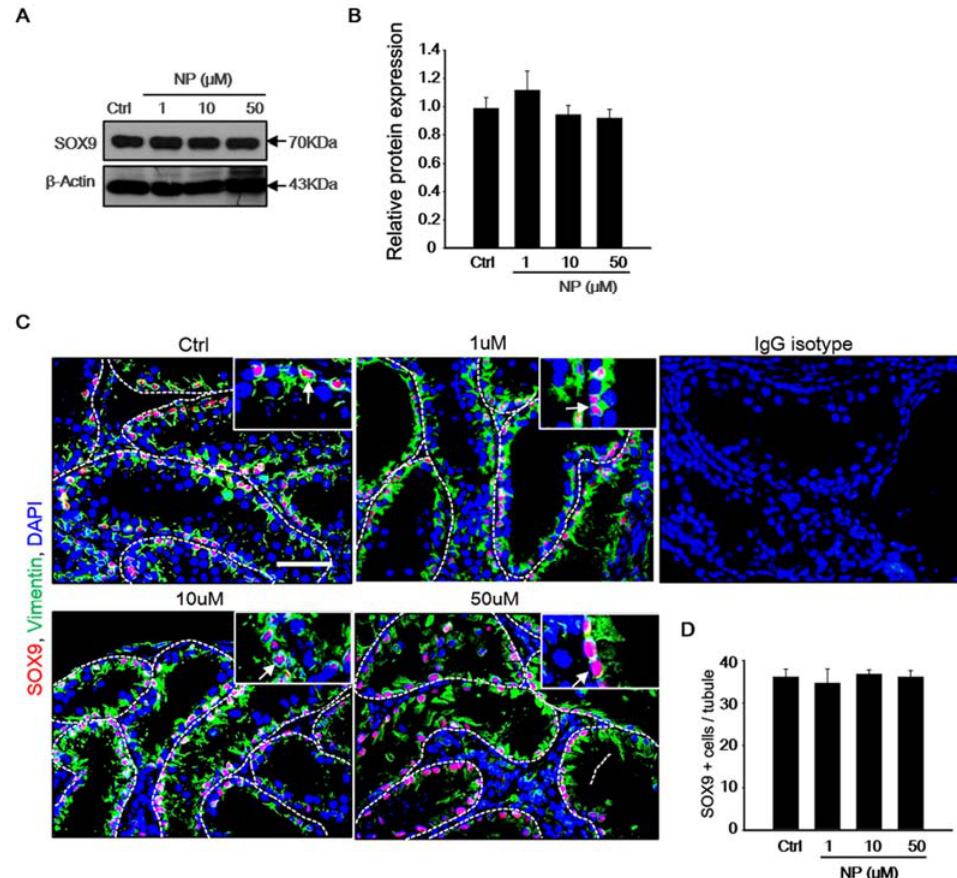
Figure 4. E ff ect of nonylphenol (NP) on Sertoli cells during mouse testicular fraction (MTF) culture. ( A ) Representative immunoblots of SOX9, a Sertoli cell-specific marker, in 30-day cultured MTFs with or without NP. β -actin was used as the loading control. ( B ) Ratios of SOX9 to β -actin are shown as the mean and the standard error of the mean ( n = 5). No significant di ff erence was noted between the 1, 10, and 50 µ M NP-treated MTFs and controls. ( C ) Double immunohistochemistry of the MTF sections was used to examine the localization of SOX9 and vimentin in MTFs cultured for 30 days with NP and with the IgG isotype-negative control. Scale bars = 50 µ m. All of the images were acquired at the same magnification. ( D ) The average number of SOX9-positive Sertoli cells in the tubules was calculated on the basis of immunostaining. At least 50 tubules were scored for each MTF (5–6 biological replicates). The expression of SOX9 and number of SOX9-positive cells in each tubule did not di ff er significantly between the NP-treated and untreated MTFs. The data are presented as mean ± standard error.